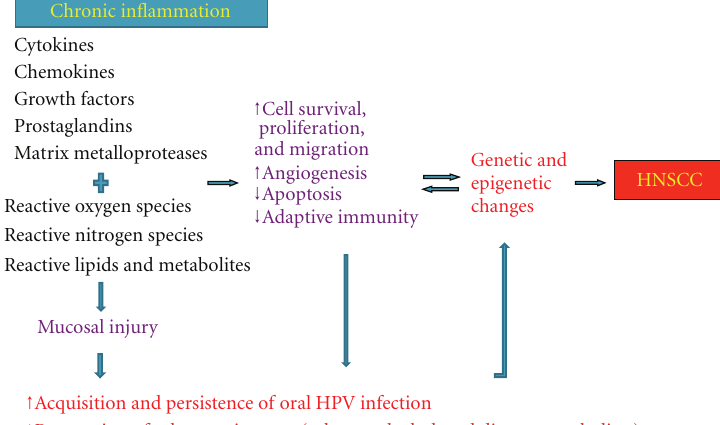
Figure 1: Model for the role of chronic inflammation in the etiology of head and neck squamous cell carcinoma